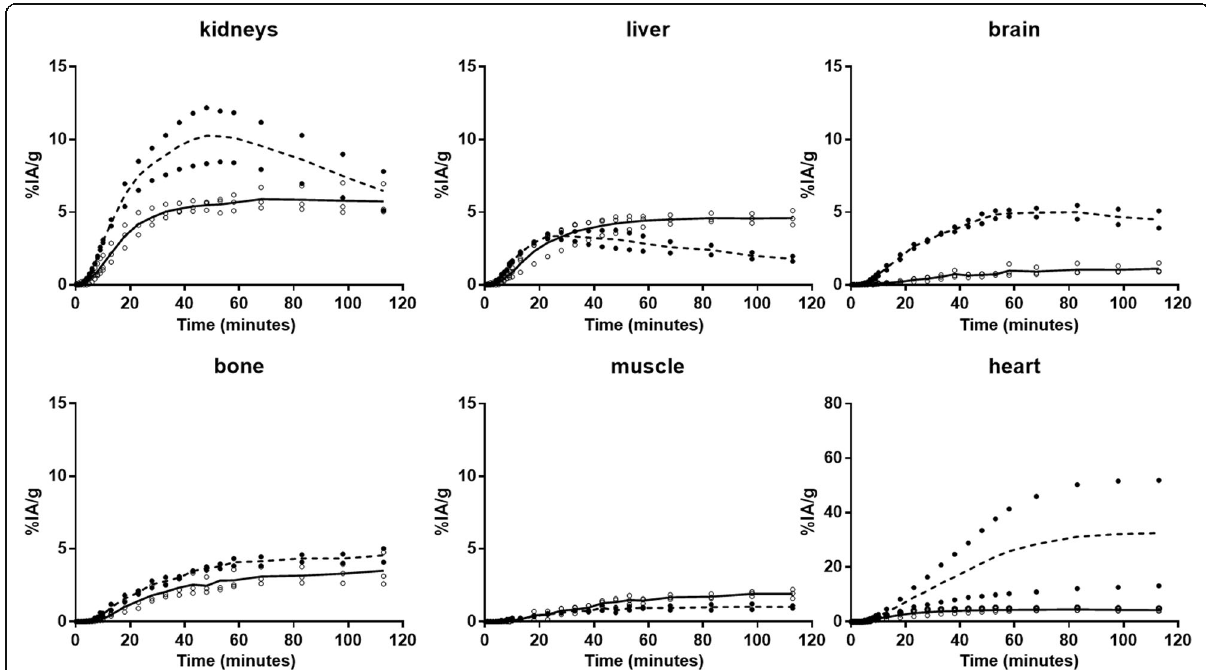
Fig. 3 Distribution kinetics and clearance of 18 F-FLT (solid line) and 18 F-FDG (dashed line) in mice bearing HCT116 human colorectal tumors after i.t. infusion of 5 MBq into the rear flank tumor. The radiotracer biodistribution kinetics were measured during 2 h by dynamic PET imaging. Data are expressed as the percent injected dose per gram of tissue (%IA/g). All data were corrected for physical decay of the isotope